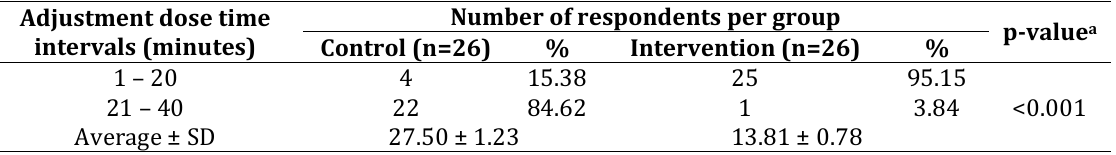
Table II. Comparison of dose adjustment evaluation time between intervention and control groups Adjustment dose time intervals